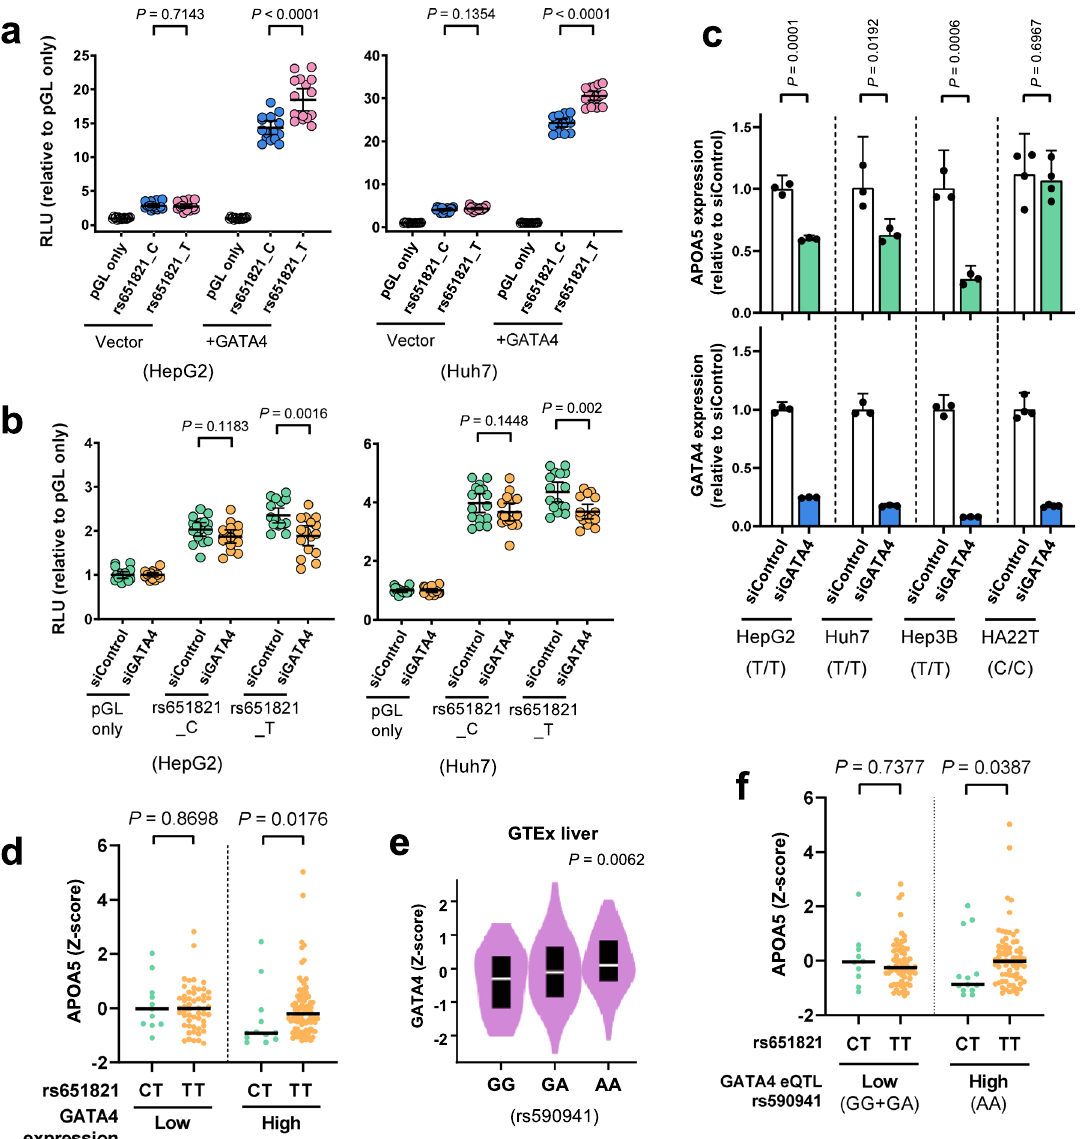
Fig. 4 Allelic imbalance in APOA5 expression is mediated by GATA4. a Reporter analysis of DNA fragments containing different rs651821 genotypes (element B) in HepG2 cells (left) or Huh7 cells (right) transfected with empty vector or GATA4-overexpressing vector. RLU relative luminescence units. b Reporter analysis of DNA fragments containing different rs651821 genotypes in HepG2 cells (left) or Huh7 cells (right) that had been subjected to knockdown by control siRNA or siRNA targeting GATA4 . P values and 95% CIs for the results are indicated; pools of four independent luciferase experiments of n = 4 are shown as dot plots. c Histogram showing relative GATA4 and APOA5 expression in liver cells transfected with control siRNA or siRNA targeting GATA4 , as determined by qPCR. The rs651821 genotype for each cell line was examined by Sanger sequencing as indicated below the graphs. At least two independent transfections of n = 3 ( n = 4 in HA22T cells) were performed, and the P values and 95% CIs are indicated. d Z scores for APOA5 expression sequentially strati fi ed by GATA4 expression and rs651821 genotypes based on the information retrieved from the GTEx liver dataset. Median values are indicated. Statistical difference between two groups was determined by the Mann – Whitney U test. e The signi fi cant GATA4 eQTL in liver tissues queried from the GTEx dataset. f Z scores